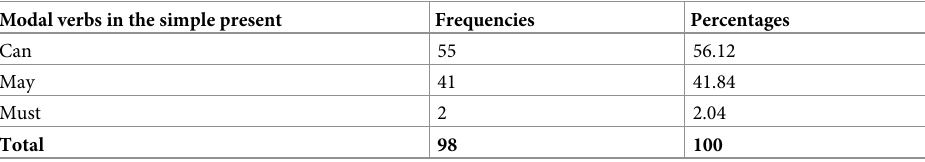
Table 15. Frequencies and percentages of modal verbs in the simple